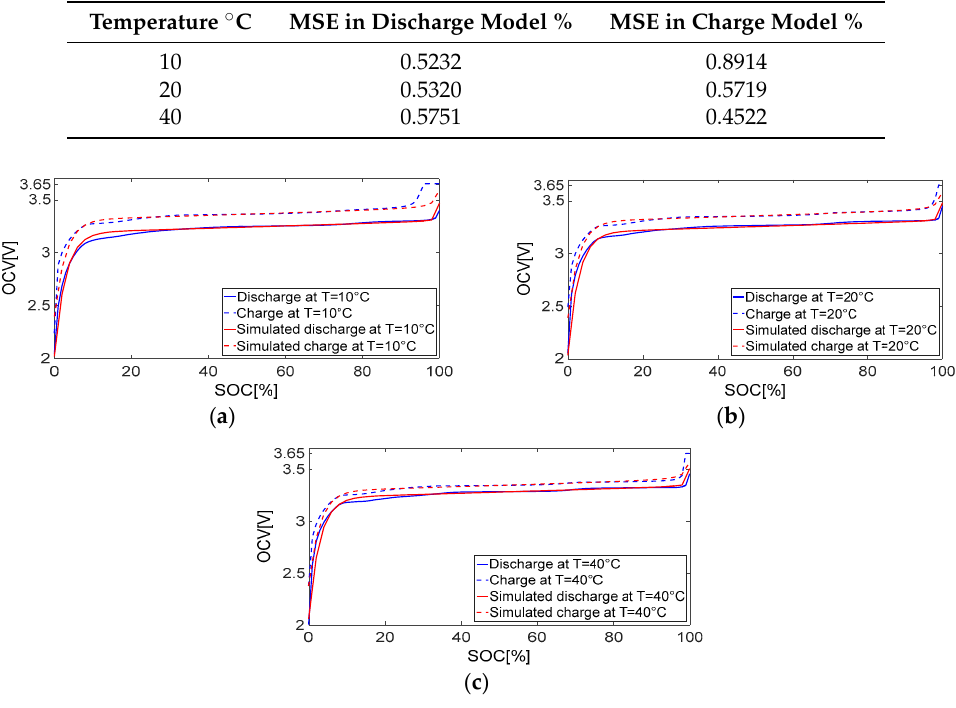
Figure 8. The new V oc model and measured experimental data: ( a ) T = 10 °C; ( b ) T = 20 °C; ( c ) T = 40 °C.